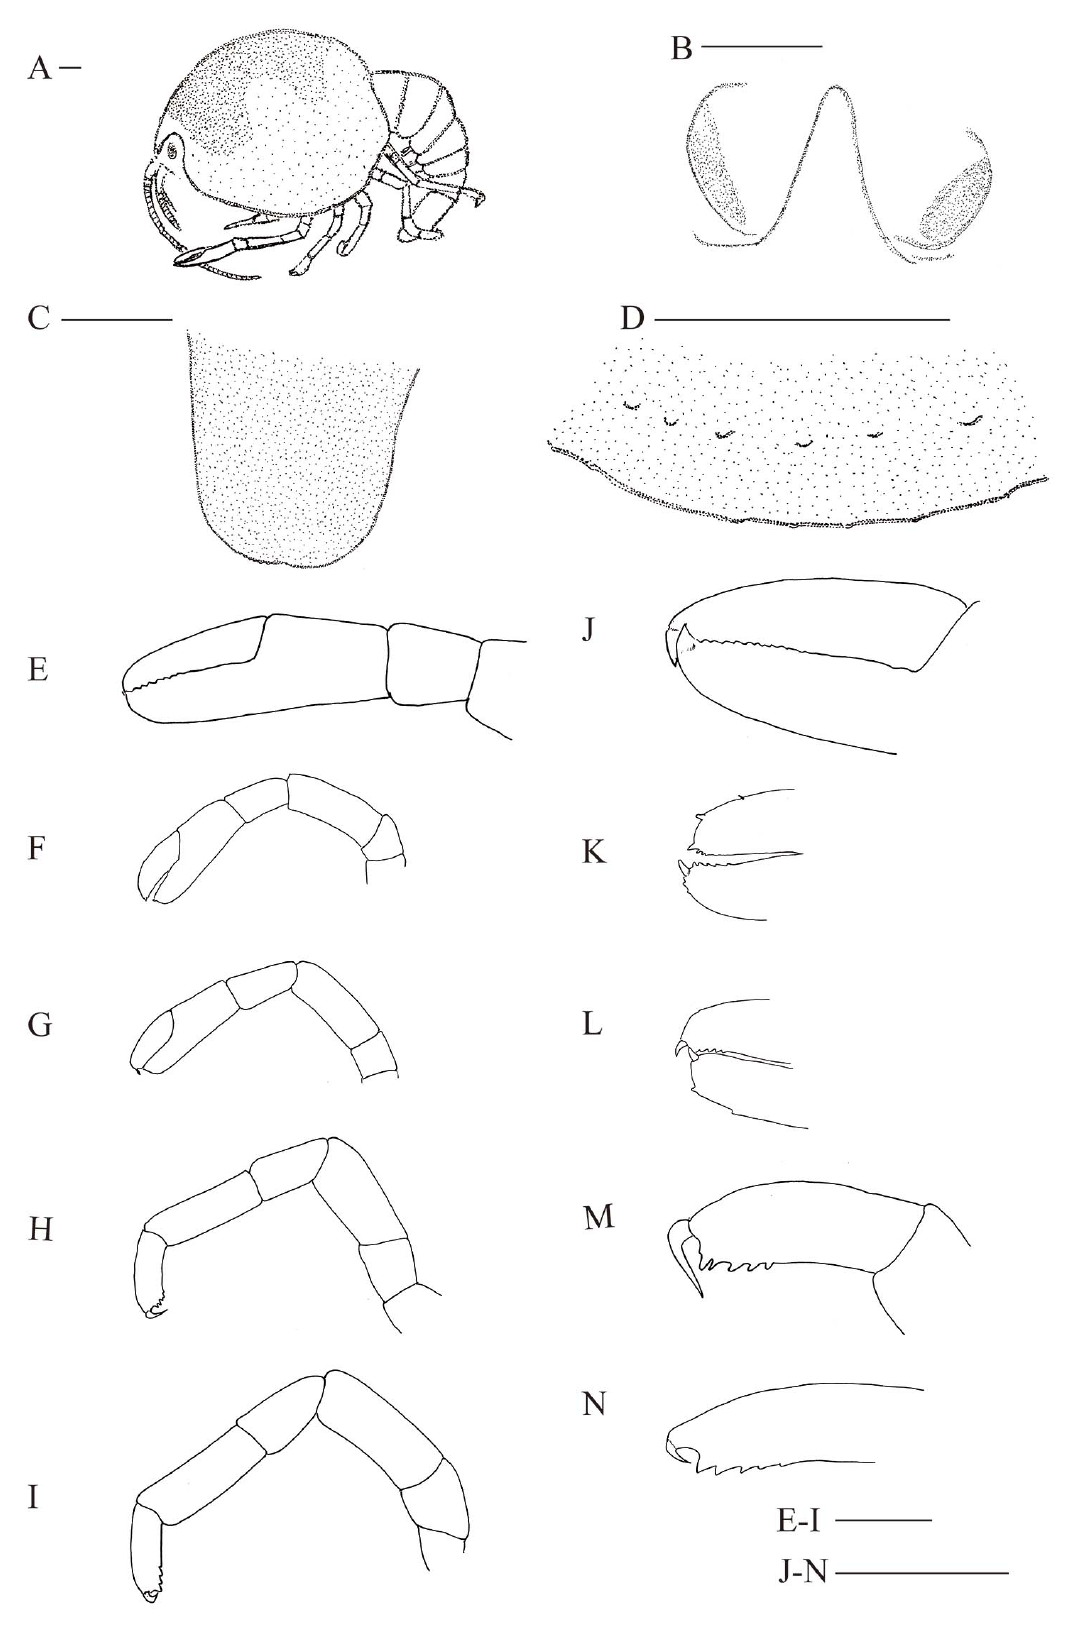
Figure 19. Juvenile Stage I of Cherax destructor . ( A ) Habitus, lateral view; ( B ) eyes and rostrum, dorsal view; ( C ) tail fan, dorsal view; ( D ) posterior edge of tail fan; ( E–I ) pereiopods 1–5, dorsal or lateral view; ( J–N ) distal segments of pereiopods 1–5, dorsal or lateral view. Scale bars: 0.25